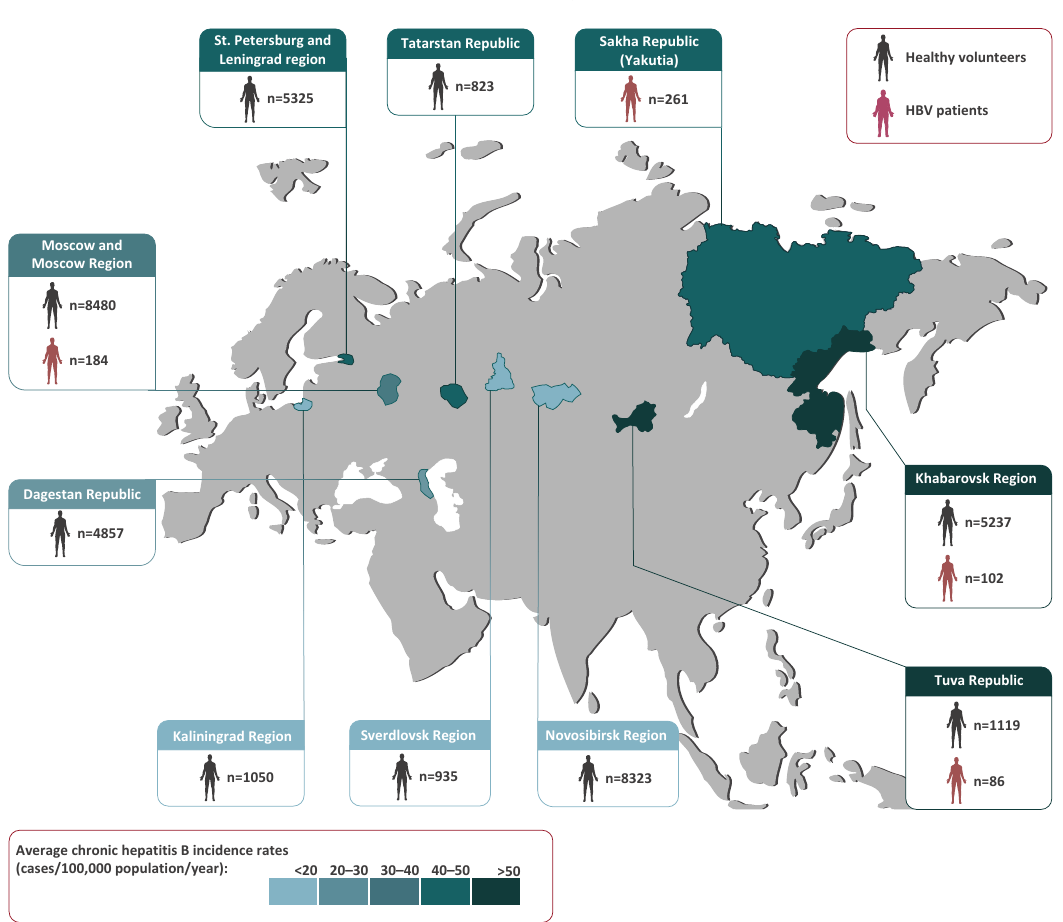
Figure 1. The study regions (in color) shown on a map of Russia alongside the numbers and sources of the samples collected in each region. The colored bar represents the 11-year average chronic Hepatitis B incidence rates (cases per 100,000 population per year) from 2010–2021, based on a federal state surveillance report